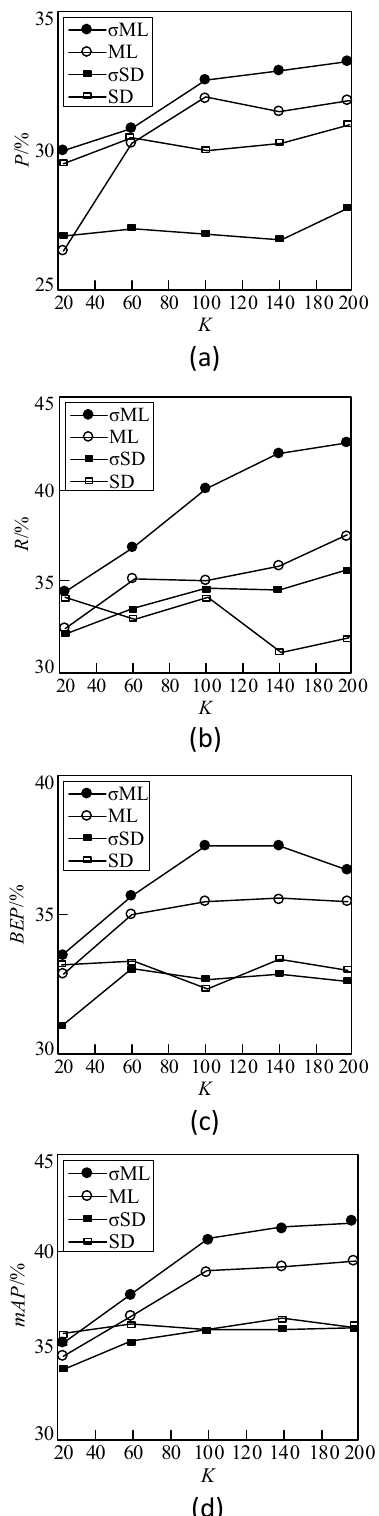
Figure 2: The relation ofneighbor size K in terms of P , R , BEP, and mAP performance based on the distance model and its variants: ( a ) P versus the number of neighbors, ( b ) R versus the number of neighbors, ( c ) BEP versus the number of neighbors, and ( d ) mAP versus the number of